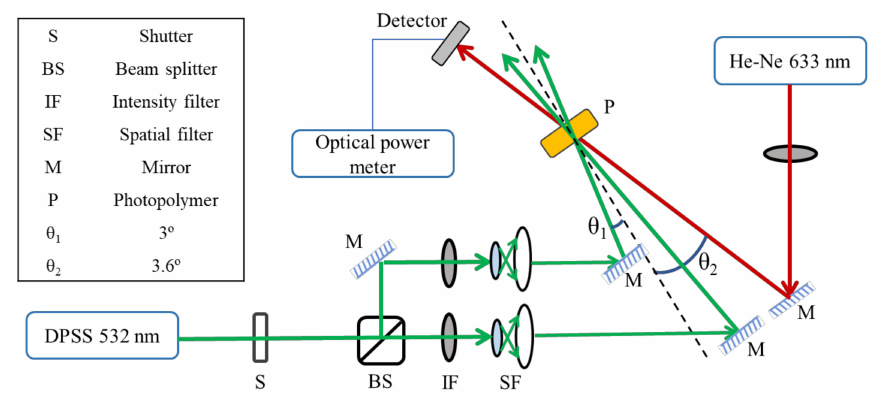
Figure 1. Holographic inscription and reading setup. Beams are colored by green and red for inscription and reading,